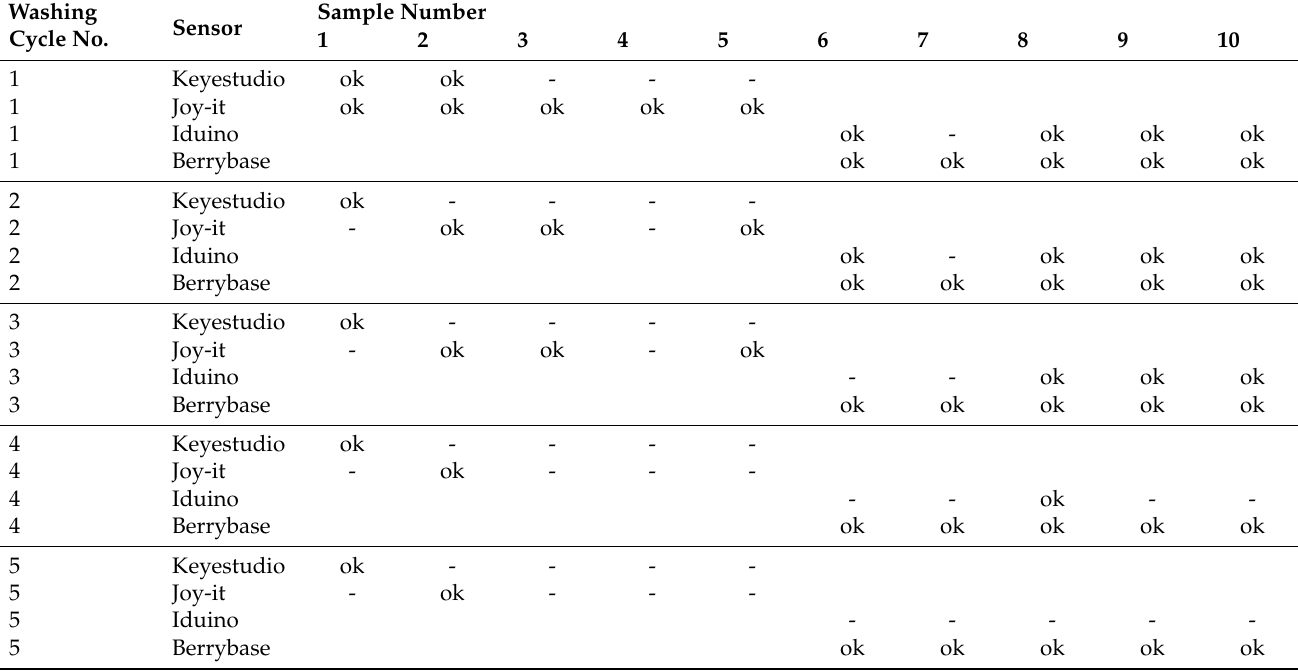
Table 2. Sensor washing tests. “-” indicates detached connector cables, “ok” means that a pulse signal could be measured. Connector cables were originally attached at Keyestudio, Joy-it and Iduino sensors, while multi-pin connectors were soldered to Berrybase sensors. Washing Cycle No.